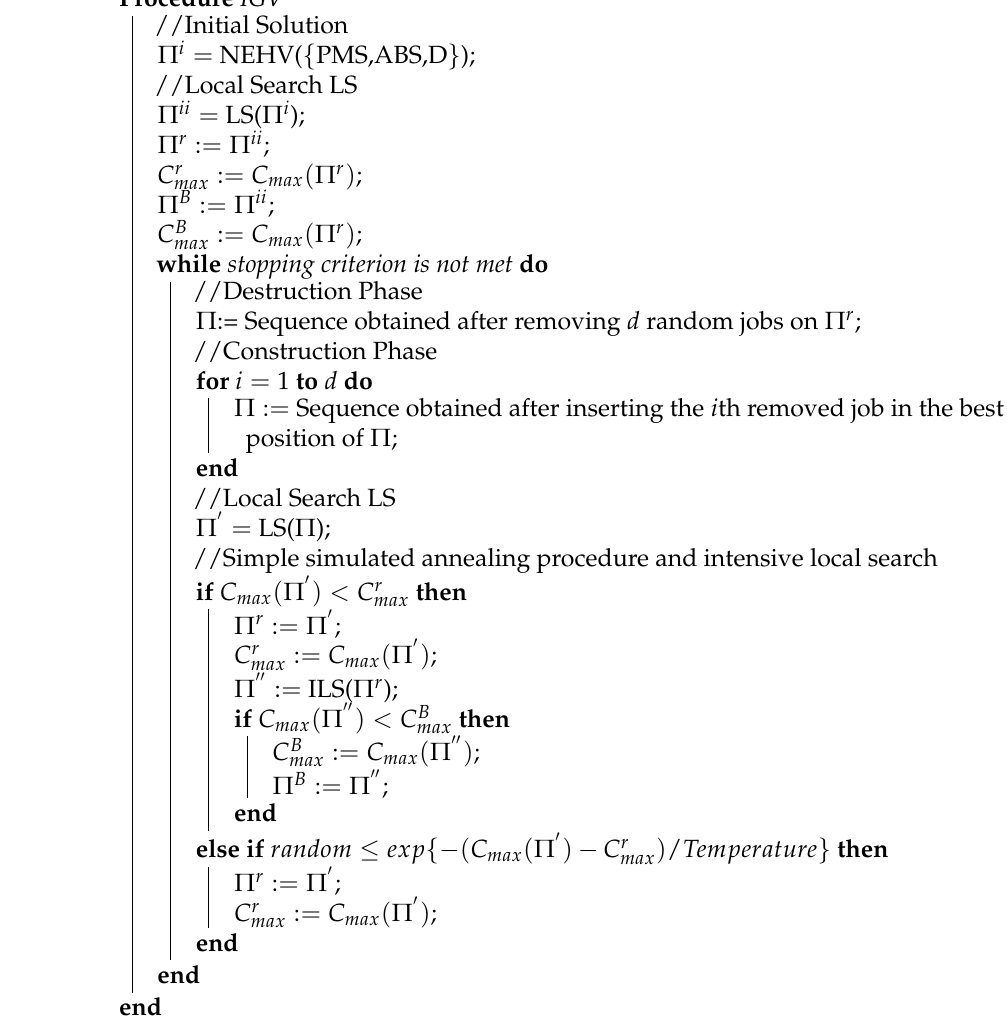
Algorithm 2: Proposed iterated greedy algorithm. Procedure